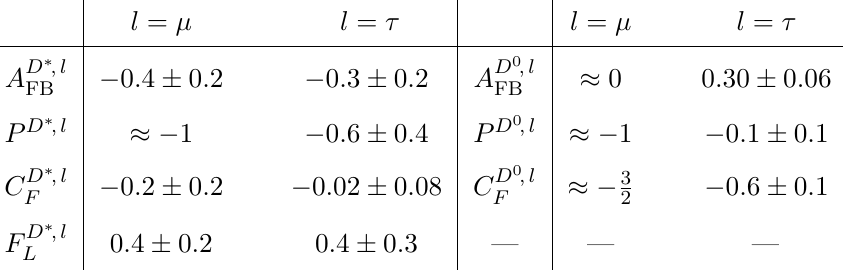
Table 6 . Angular observables integrated over the entire kinematic